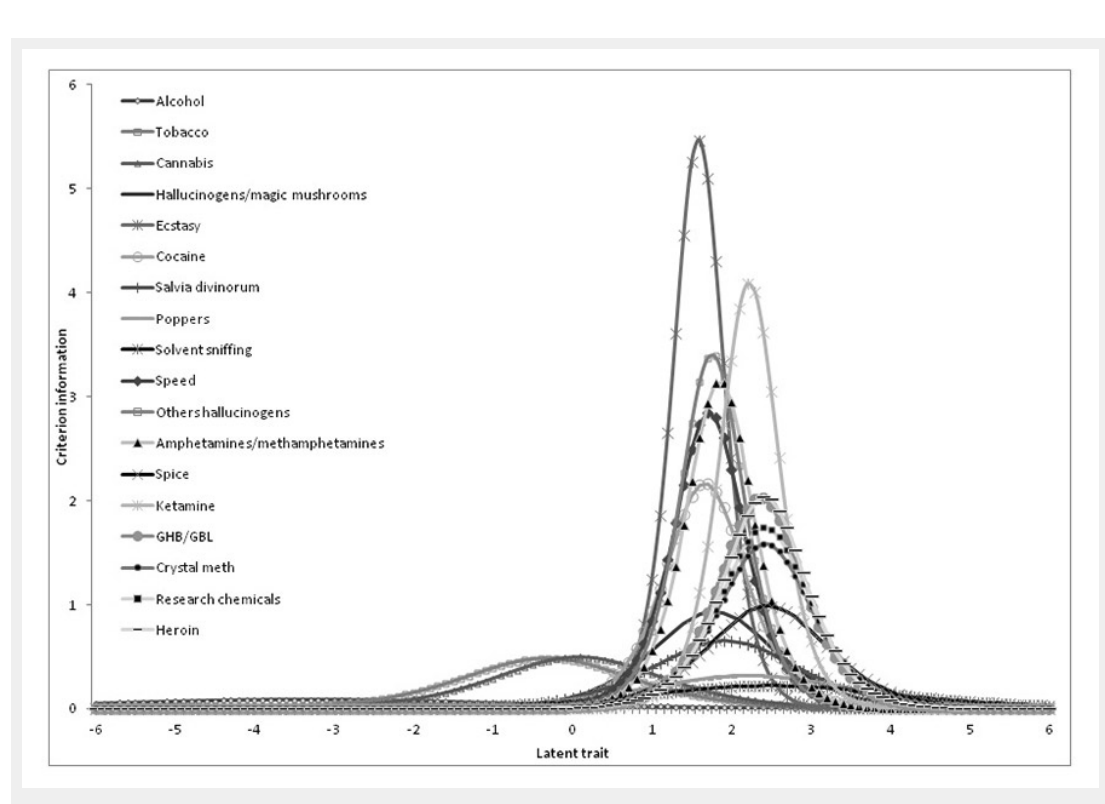
Criterion information curves for drug use. The criterion information curves represent how each criterion measured the underlying latent trait. The point on the x-axis where the probability of endorsement (y-axis) is 50% determined the severity parameter. The discrimination parameter of each criterion is the slope: the steeper slopes had higher discrimination parameters. Thus, ecstasy and ketamine discriminate very strongly between different drug users (high values on the y-axis), whereby ecstasy is less severe (more left = 1.59) compared with ketamine (more to the right with severity = 2.23) as regards the latent trait (substance use severity). (Detailed values can be found in table